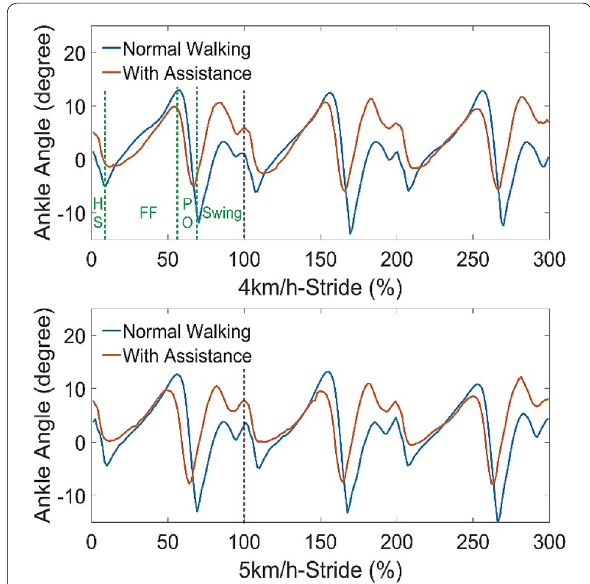
Figure 10 Comparison of the ankle angle between normal walking and assisted walking at different walking